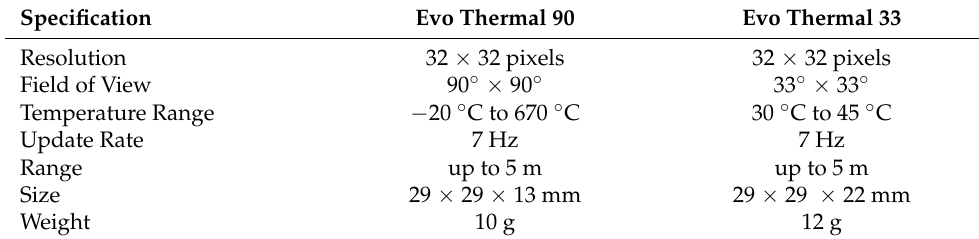
Figure 4. Schematic for the field of view of the sensor attached to the flange of the robot. Table 3. Teraranger Evo Thermal Specifications [31].